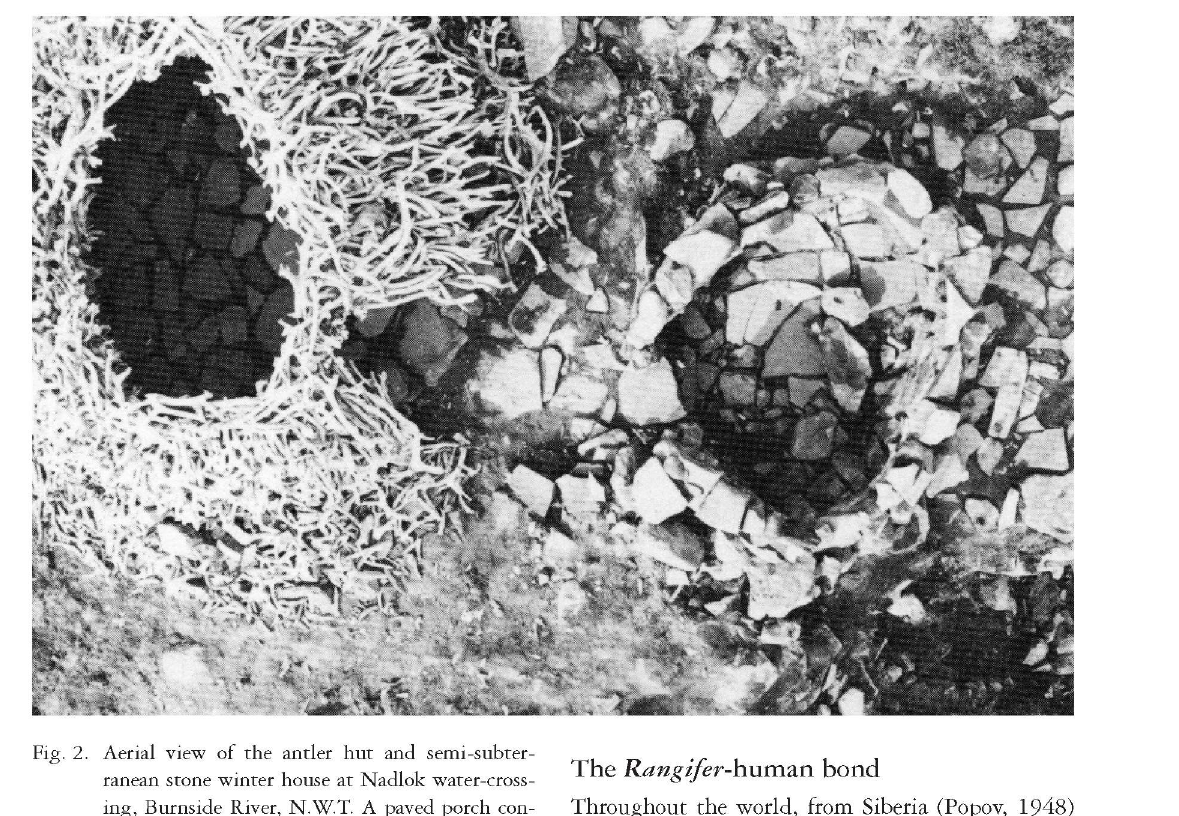
Fig. 2. Aerial view of the antler hut and semi-subter- u 11 i , The Rangifer-human bond r ranean stone winter house at Nadlok